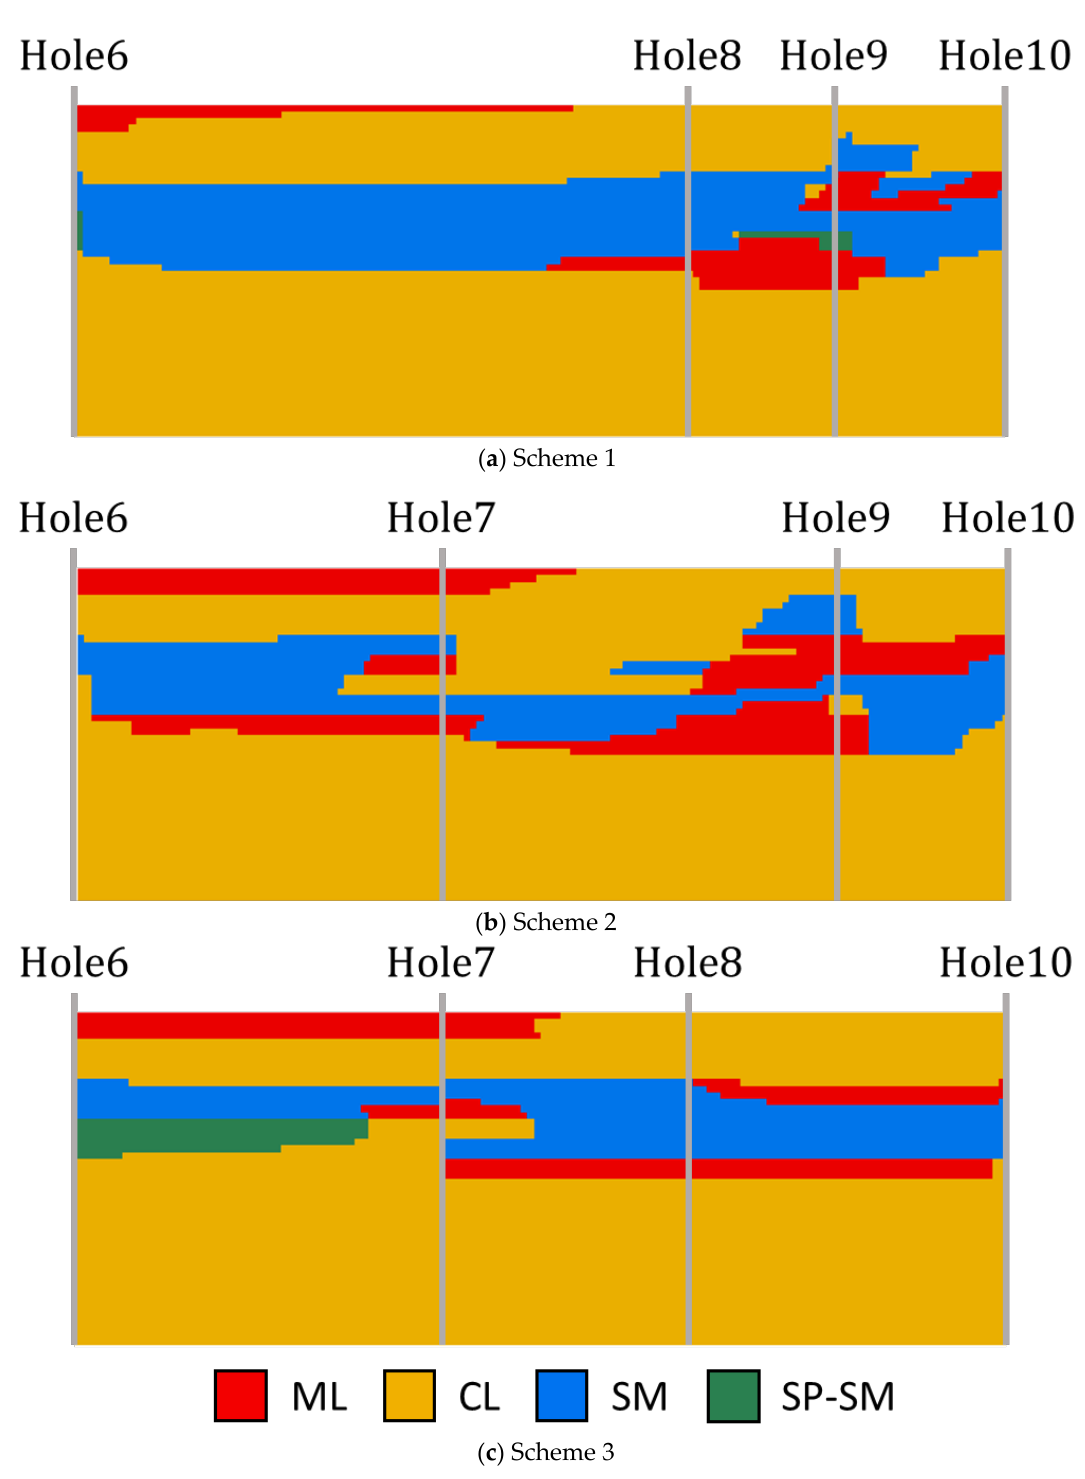
Figure 7. Stratigraphic profiles generated through Kriging interpolation.